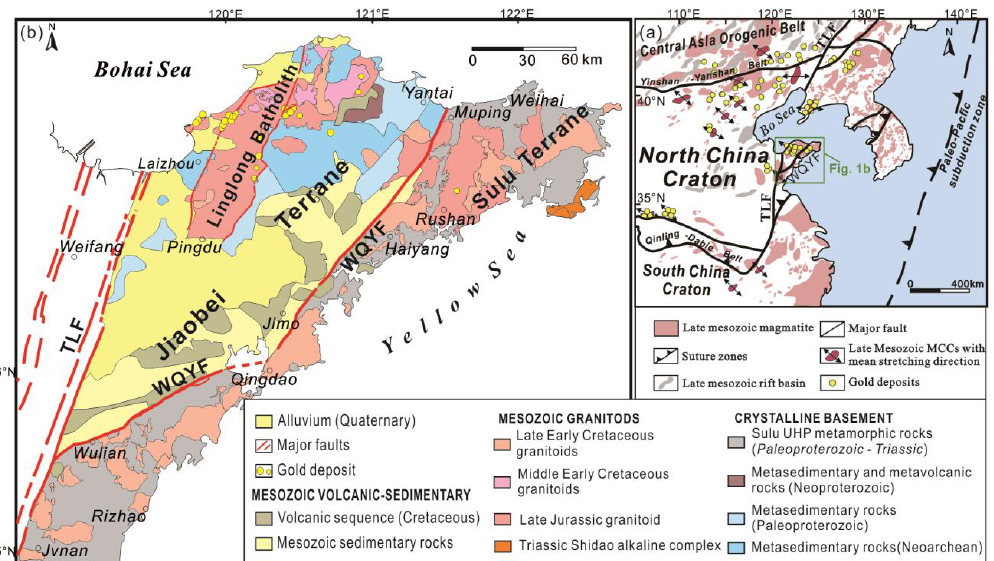
Figure 1. ( a ) Simplified tectonic map of East China illustrating the locations of Palaeo-Pacific sub- duction zone and Jiaodong Peninsula. Adapted with permission from [15]. ( b ) Simplified geological map of the Jiaodong Peninsula illustrating the major faults, large-scale Mesozoic magmatism, and typical gold deposits. Adapted with permission from [6]. Main faults: TLF, Tan-Lu Fault; WQYF, Wulian-Qingdao-Yantai Fault.